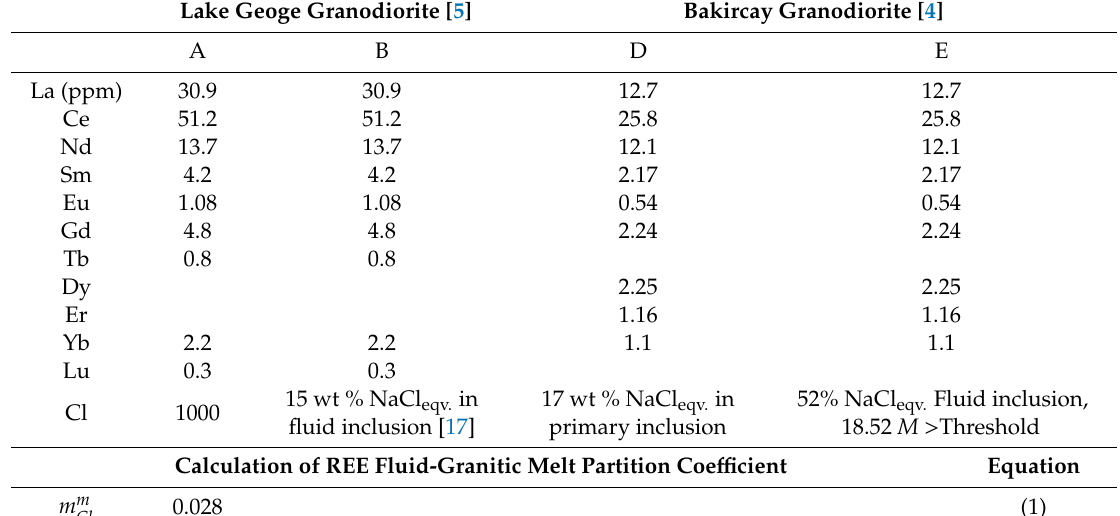
Table 4. Calculation of REE concentrations in a magmatic